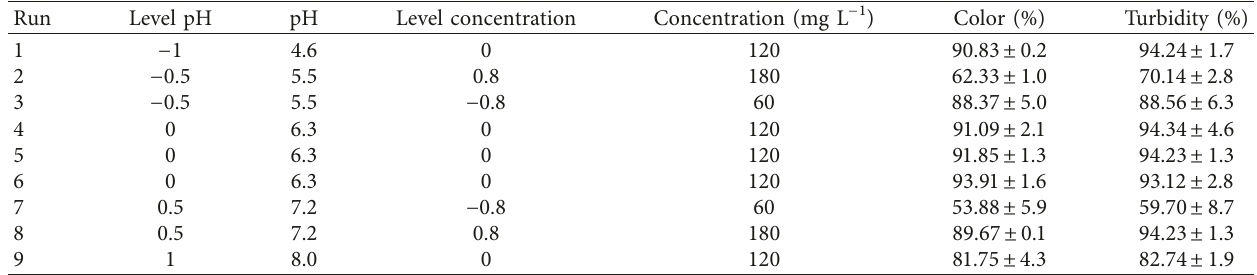
Table 4: Doehlert design matrix and removal of color and turbidity of the wastewater (batch 1) using the Tanfloc POP ® coagulant. Run Level